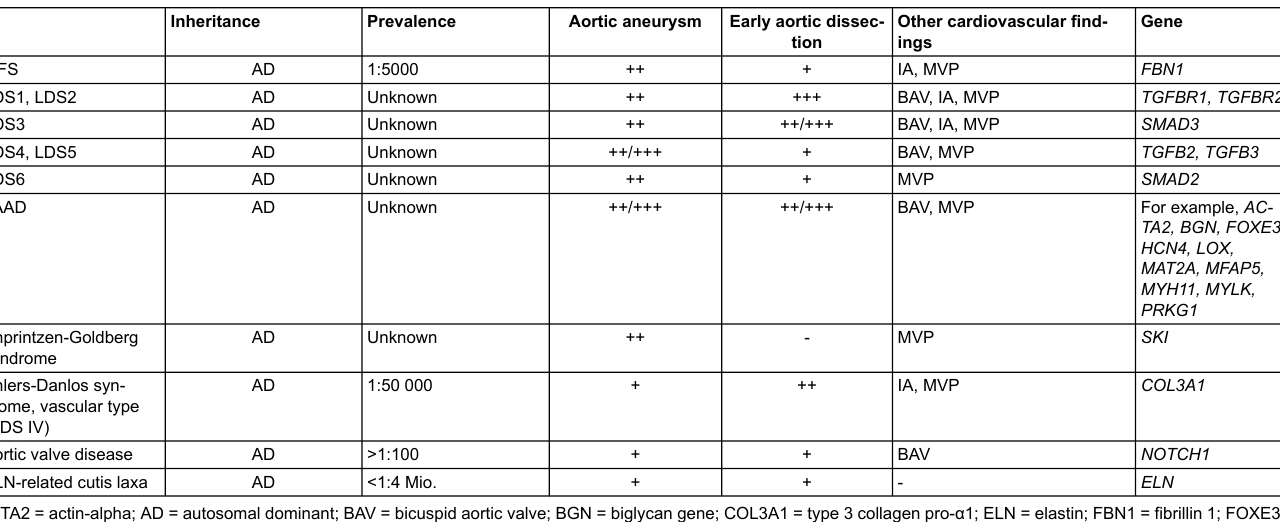
Table 1: Differential diagnosis of Marfan